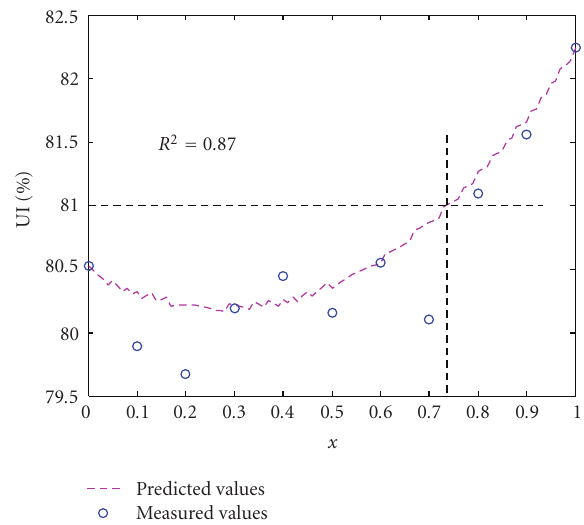
Figure 20: UI% values determined from established distribution functions and those of real